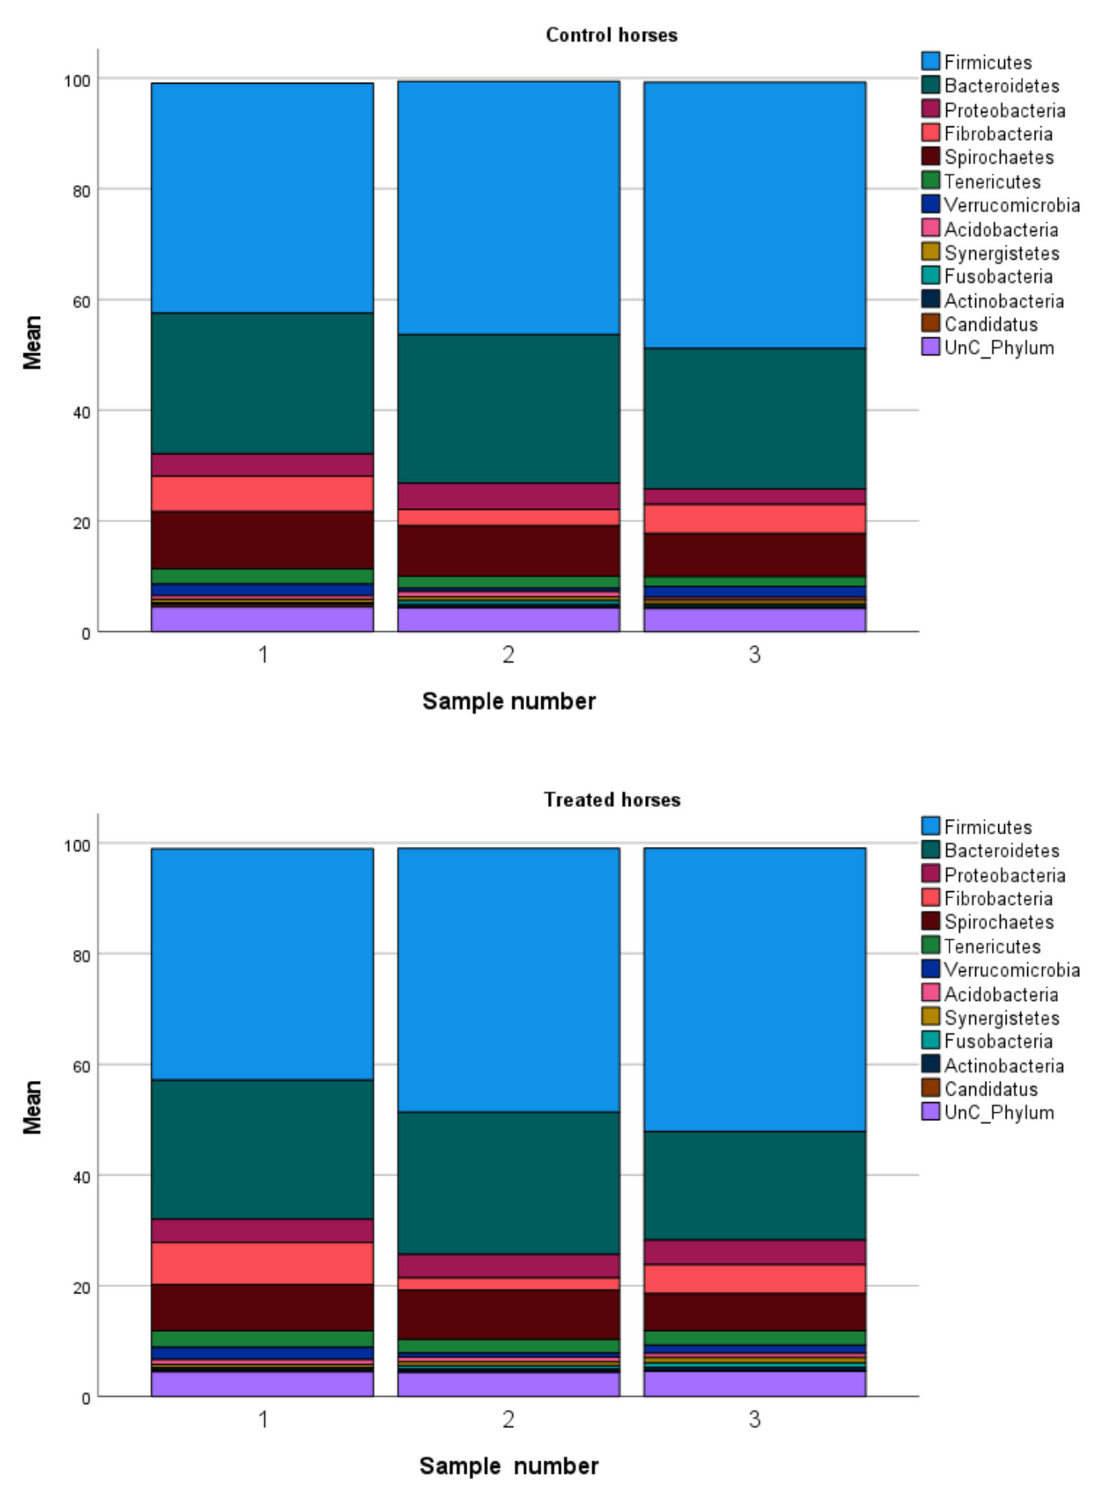
Figure 2. Microbiome composition showing mean relative abundances of 12 bacterial phyla and an unclassified category for 10 control horses and 12 treated horses given a prebiotic nutritional supplement at baseline and at 6- and